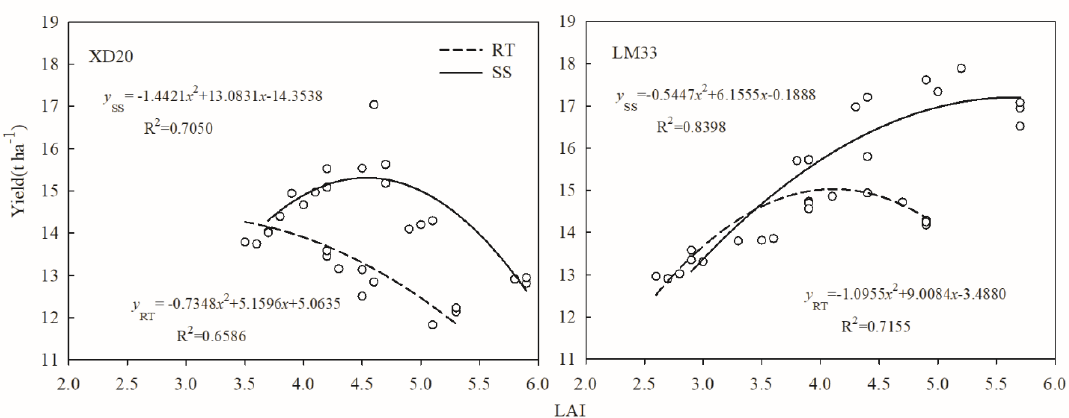
Figure 4. Regression analysis of LAI and yield for high-yielding spring maize.